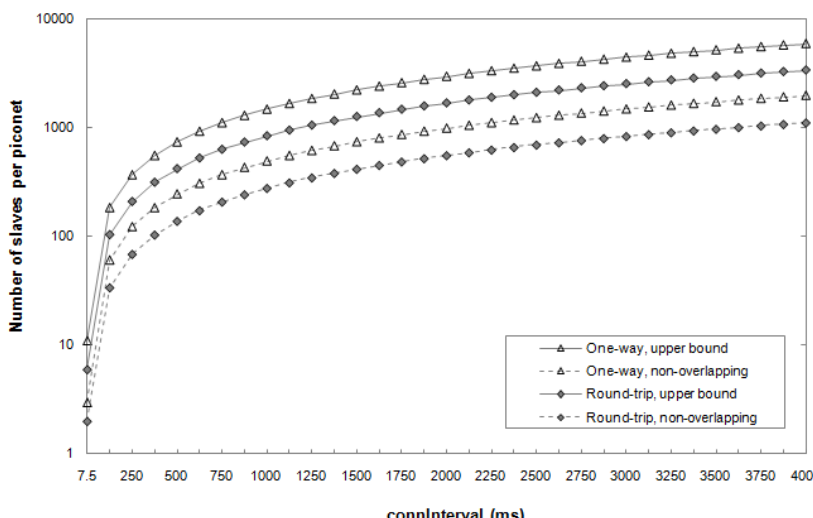
Figure 15. Theoretical maximum number of slaves per piconet for various types of interaction between devices, scheduling schemes and connInterval . The different types of interaction examined are the one-way and round-trip communications (described in Section 2.2.2). Moreover, the analysis has been done in the ideal case of non-overlapping communications, as well as in the case of overlapping, which denotes the upper bound limit. Adapted from